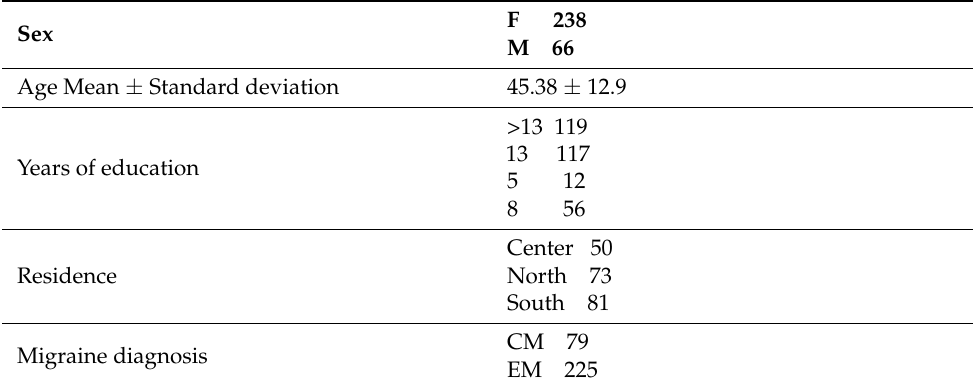
Table 1. Demographic data of migraine sample.